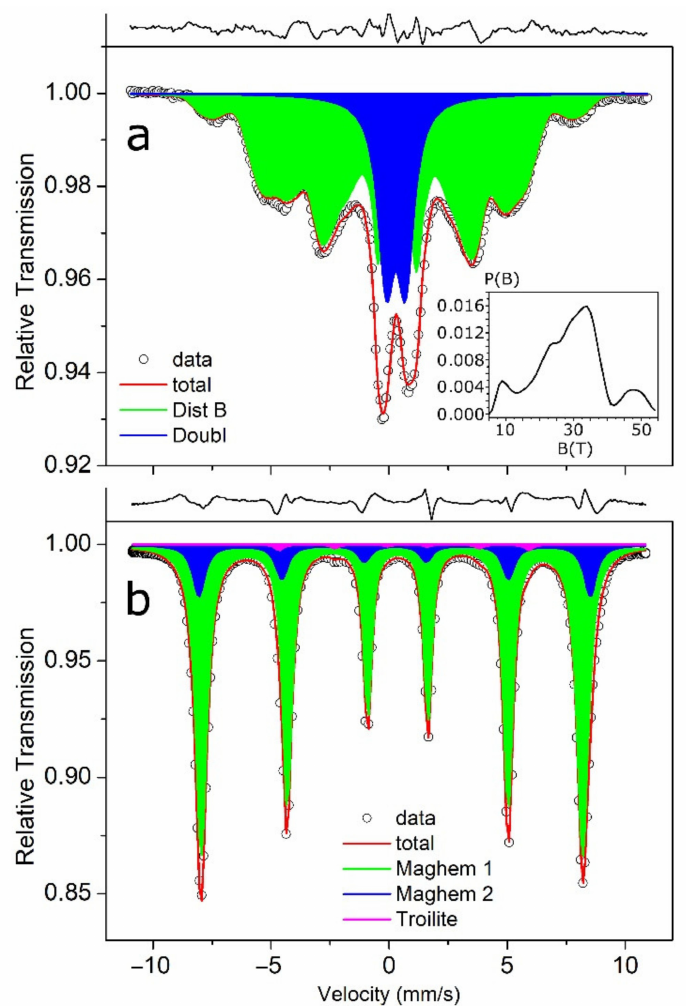
Figure 16. Mössbauer spectra obtained for NWA1990 stony meteorite at ( a ) RT and ( b ) 4.2 K. The inset in ( a ) represents the distribution of the hyperfine